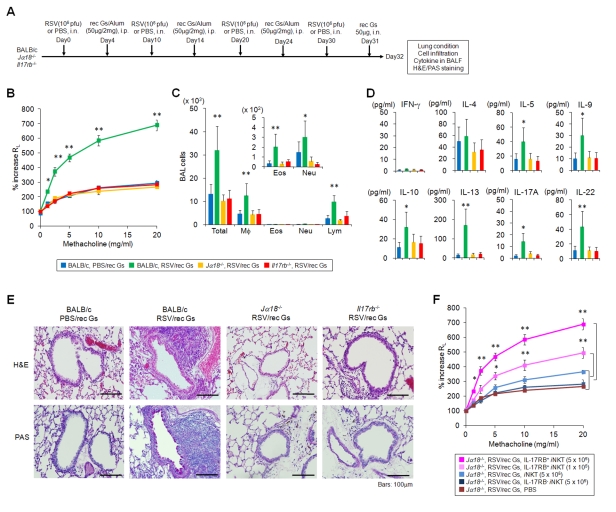
Involvement of IL-17RB+
iNKT cells in the development of RSV-induced AHR.(A) Schematic showing the protocol for RSV-induced AHR. Mice were i.n. administered with RSV (106 pfu) or PBS alone as a control 4 times at 10-day intervals. Mice were i.p. immunized with rec Gs/alum (50 µg/2 mg) 4 d after first RSV infections. Three days after the last RSV administration, mice were exposed i.n. to rec Gs and were measured 1 d later. (B) Development of RSV-induced AHR in BALB/c, but not in Jα18
−/− or Il17rb
−/− mice. Changes in RL are depicted. The RSV-infected, rec Gs immunized, BALB/c mice had a greatly increased AHR compared to the other three groups. Results are expressed as the mean ± SEM. * p<0.05 and ** p<0.01. (C, D) Total and differential cell counts (C) and cytokines (D) in BAL fluid. BAL fluid was collected 24 h after challenge of the mice depicted in (B) with intranasal rec Gs. Results are expressed as the mean ± SEM. * p<0.05 and ** p<0.01. (E) Histological examination of lung tissues by H&E and PAS staining. RSV infected, rec Gs immunized, BALB/c, Jα18
−/− or IL17rb
−/−, mice were compared with control BALB/c mice (rec Gs alone). Bars indicate 100 µm. (F) AHR development after cell transfer of spleen IL-17RB+
iNKT cells into Jα18
−/− mice. Indicated cell numbers of sorted IL-17RB+, IL-17RB−
iNKT cells or total iNKT cells from spleen, or PBS control, were i.v. transferred into rec-Gs/alum-sensitized Jα18
−/− mice 24 h before RSV treatment (on the day 9, 19, and 29), and then challenged with rec Gs (24 h) and measurement of lung resistance (48 h). Each group of IL-17RB+
iNKT cell-transferred mice was compared to other three groups. * p<0.05, ** p<0.01 calculated by Kruskal Wallis test. The results represent one out of four experiments with five mice in each group.